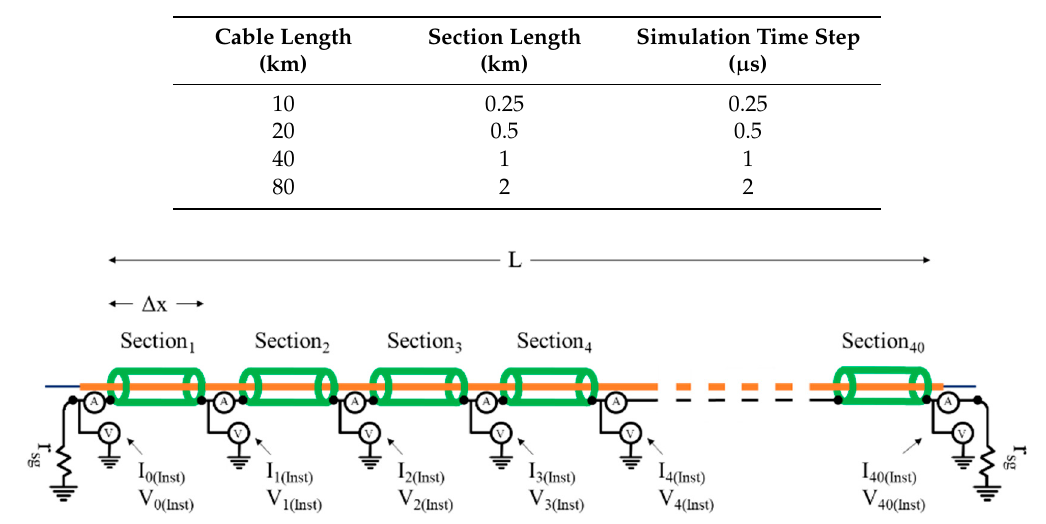
Table 1. Simulation Time Steps According to Cable Length.